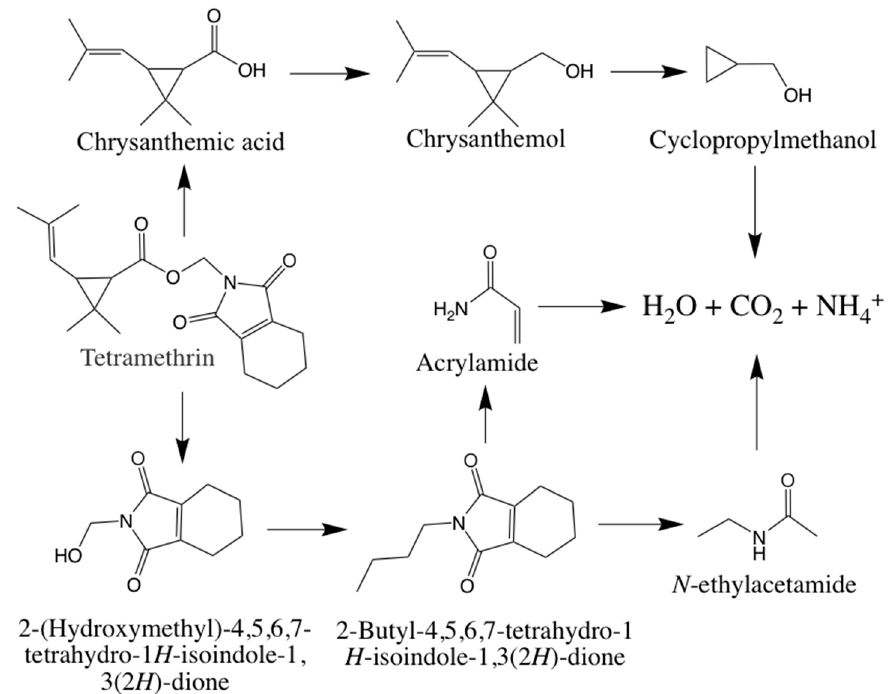
Figure 8. Proposed tetramethrin degradation pathway in strain A16.